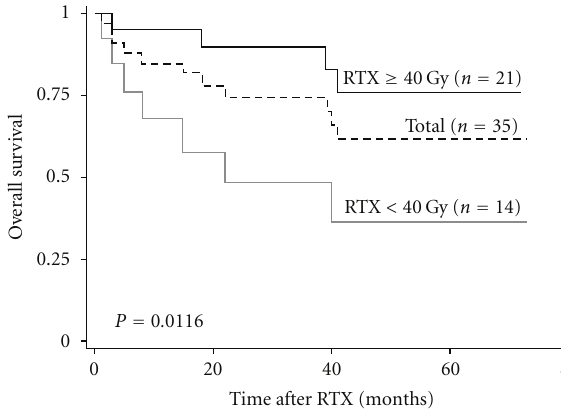
Figure 1: The overall survival curves for all patients ( n = 35) and those that received a total radiotherapy dose of ≥ 40 Gy ( n = 21) or < 40Gy ( n = 14). RTX,